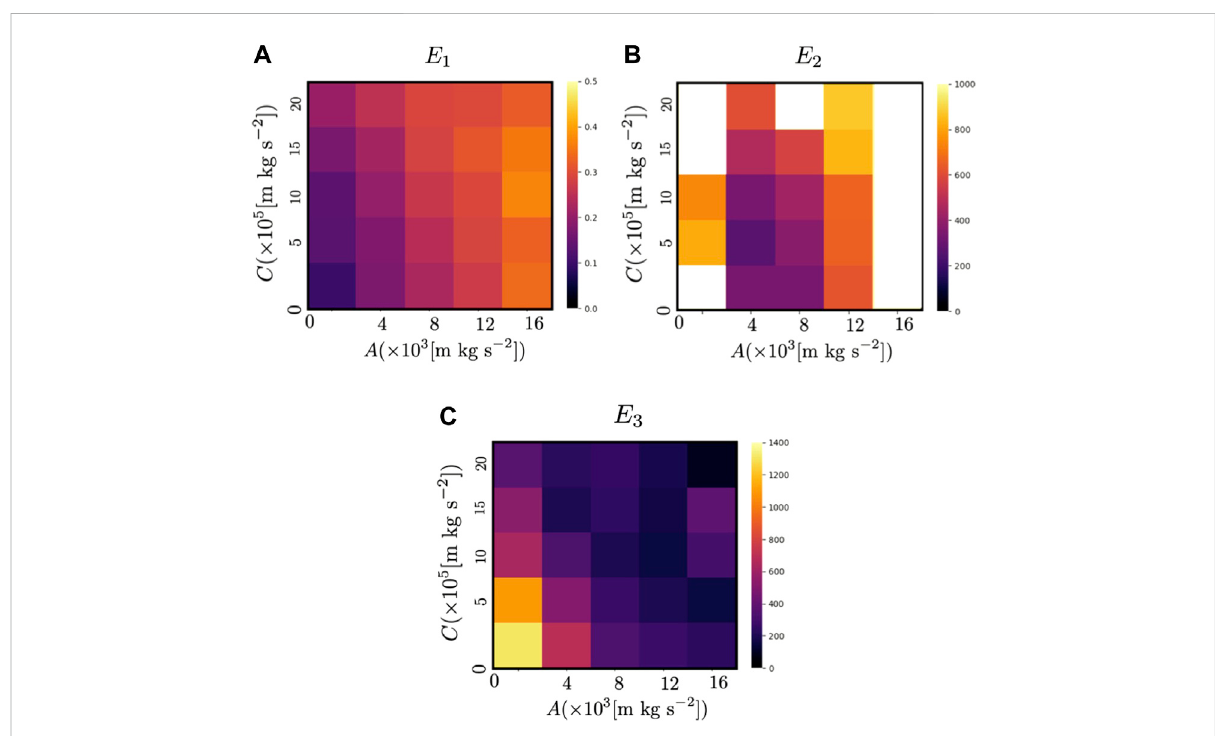
FIGURE 15 Color mapof (A) E 1 , (B) E 2 , and (C) E 3 for theproposed modelwhen N =50.The colorindicatesthevalues oftheindices( E 1 , E 2 and E 3 )whenthe parameters A and C ,whichdeterminethemagnitudeoftherepulsiveforcefromotheragentsandtheavoidanceforcebasedonthepredictionofthe future motion of other agents, respectively (Eqs. 12, 16)were varied. White areas indicate that the value exceeded the range shown in the color